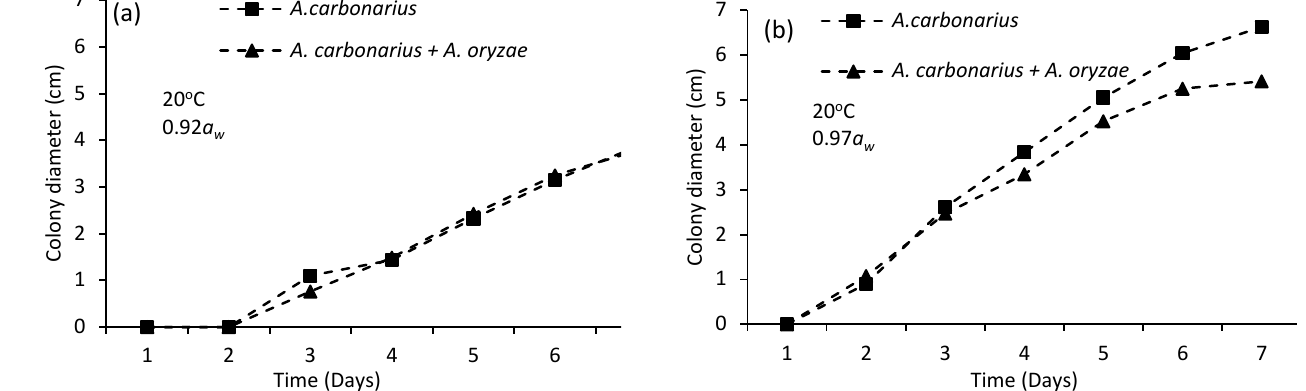
would be adequate to inhibit the growth of A. carbonarius at a high water activity (0.97 a w ).